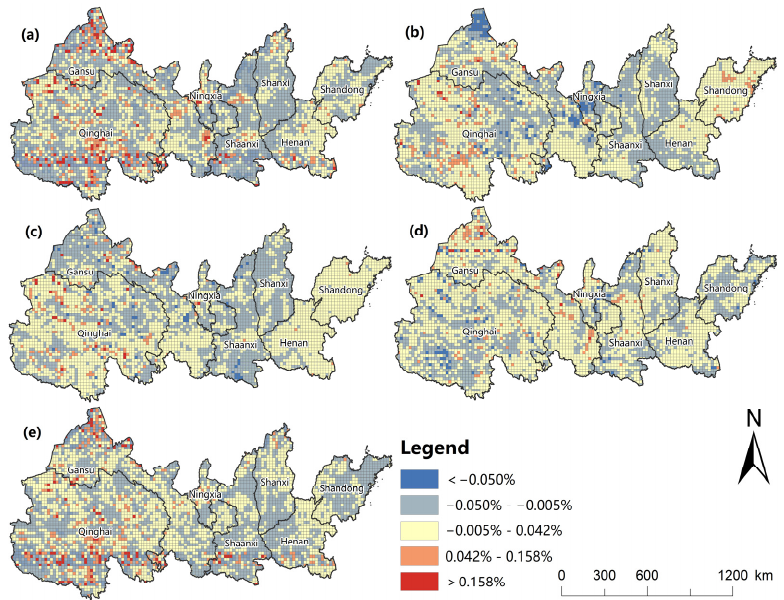
Figure 8. Risk rate of change spatial shows during 2000–2020 ( a ), 2000–2005 ( b ), 2005–2010 ( c ), 2010–2015 ( d ), and 2015–2020 ( e